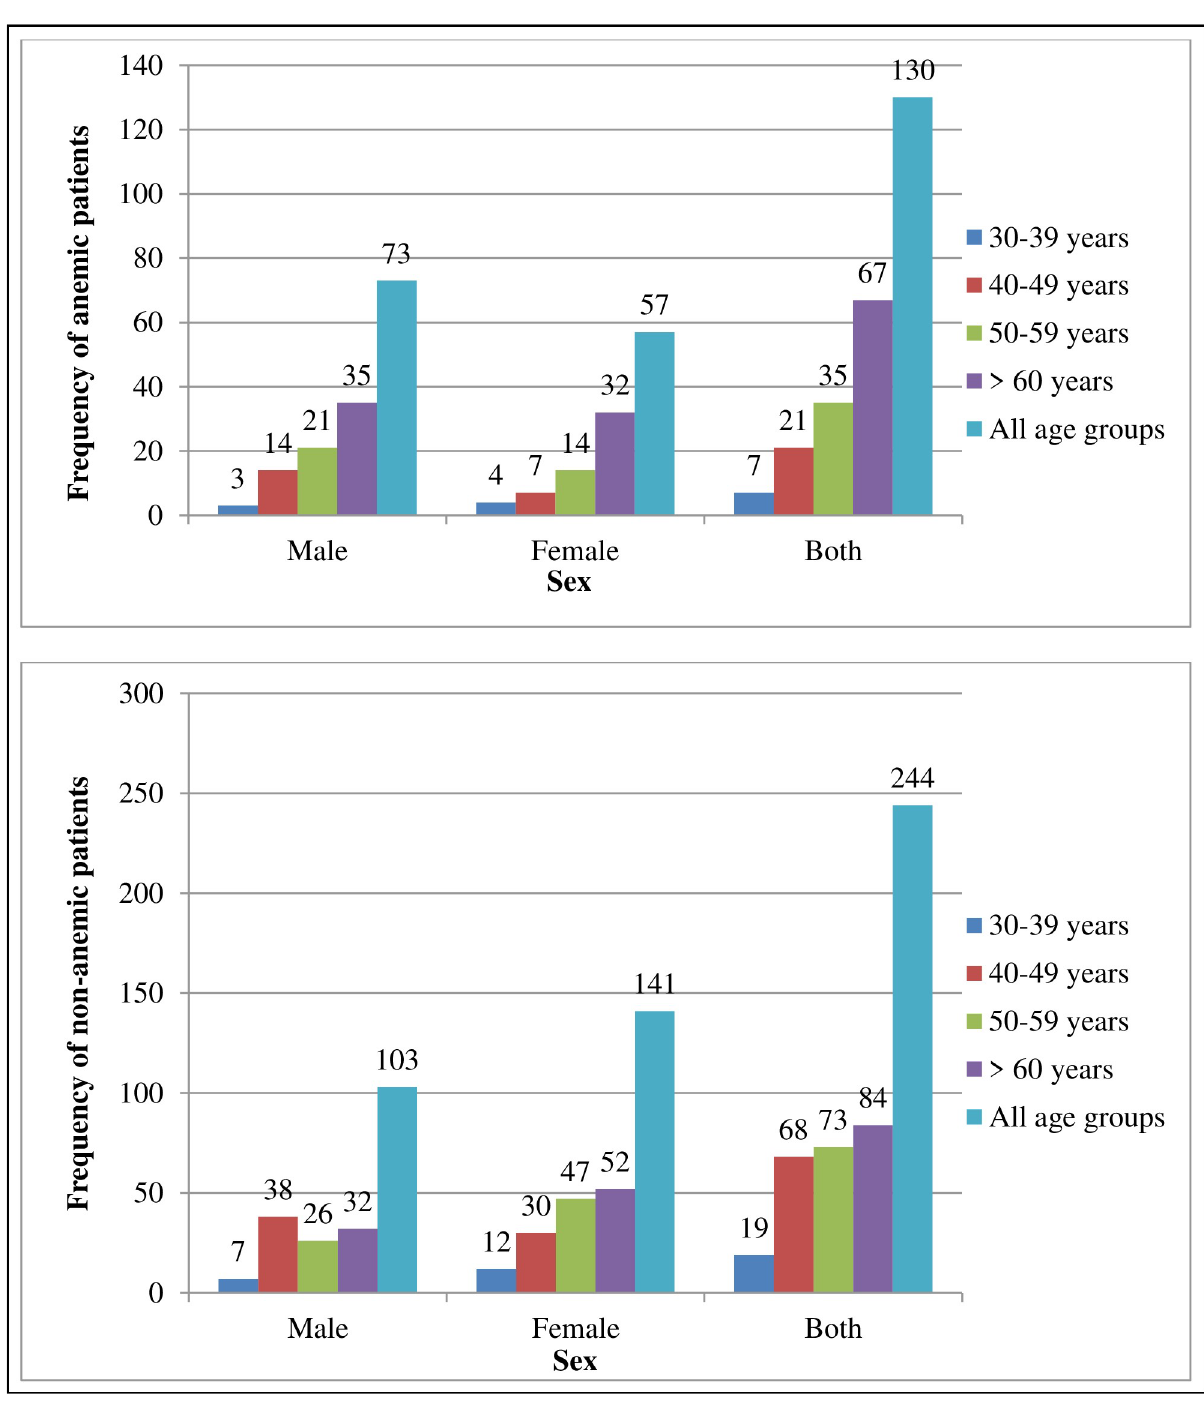
Fig 3. Sex and age distribution among anemic and non-anemic T2DM patients attending public hospitals in Harari Region, Eastern Ethiopia, February to March 2019 (n = 374).